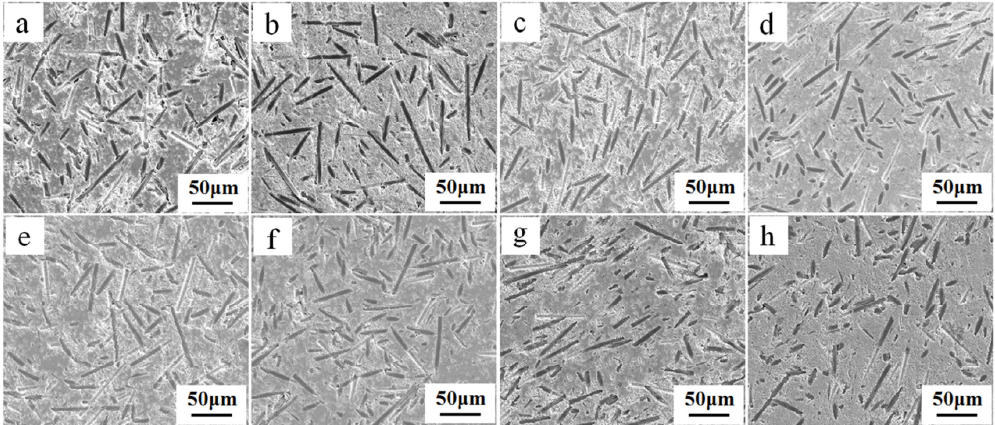
Fig. 9 SEM images of the sample ZSC30 after being water-quenched with different temperature differences: (a) 0 ℃ , (b) 200 ℃ , (c) 300 ℃ , (d) 400 ℃ , (e) 500 ℃ , (f) 600 ℃ , (g) 700 ℃ , and (h) 800 ℃ . No micro-cracks are found on these samples indicating a good resistance for crack initiation and crack propagation during rapid